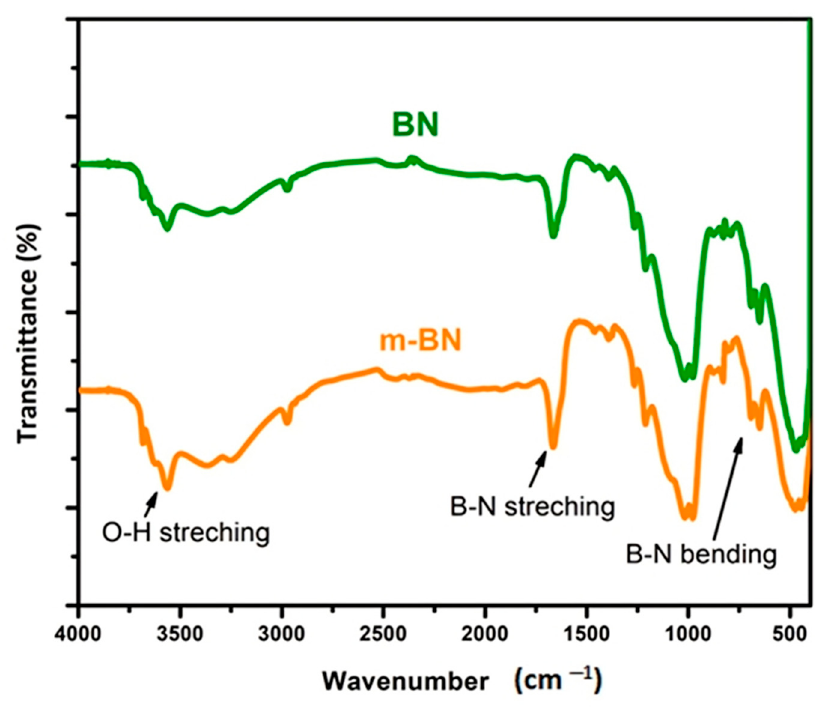
Figure 4. FTIR of pristine and m-BN powder.